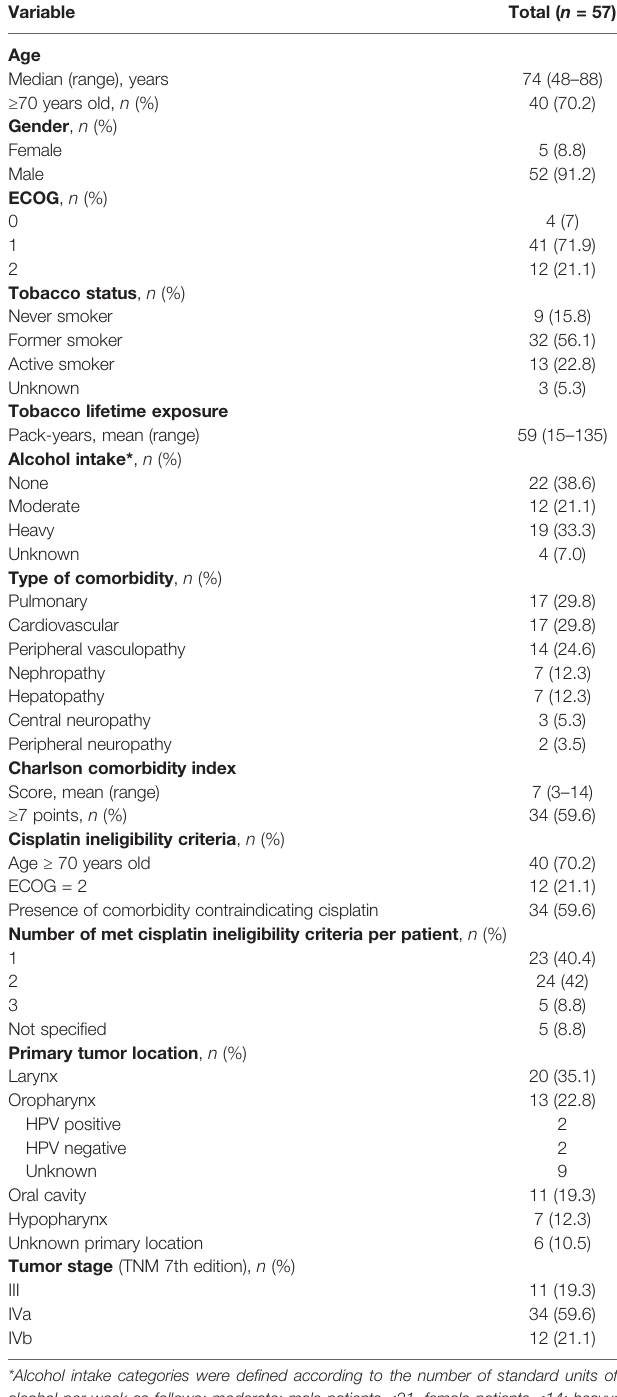
TABLE 2 | Baseline patient and tumor characteristics of the whole cohort.